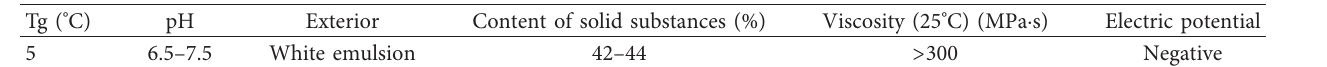
Table 2: Emulsion performance parameters.